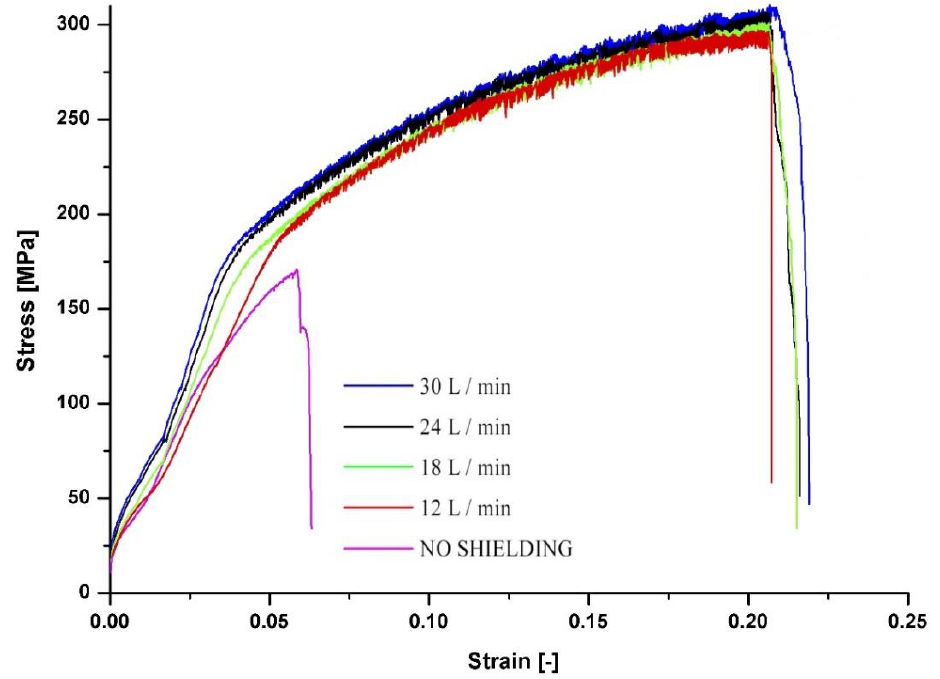
Figure 17. Stress–strain curves for the welds created with various gas flow rates.